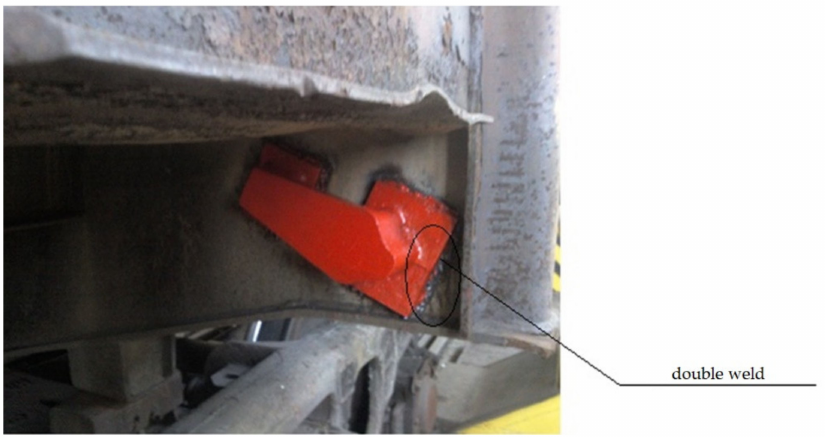
Figure 14. Location of the fixation unit for chain binders on the bolster beam of an open car. The wire slings with a weight capacity of 196.2 kN were used in designing the chain binders. One end of the sling was fixed on the unit, and the other end was fixed by a bracket welded to the 50-millimeter metal sheet (Figure